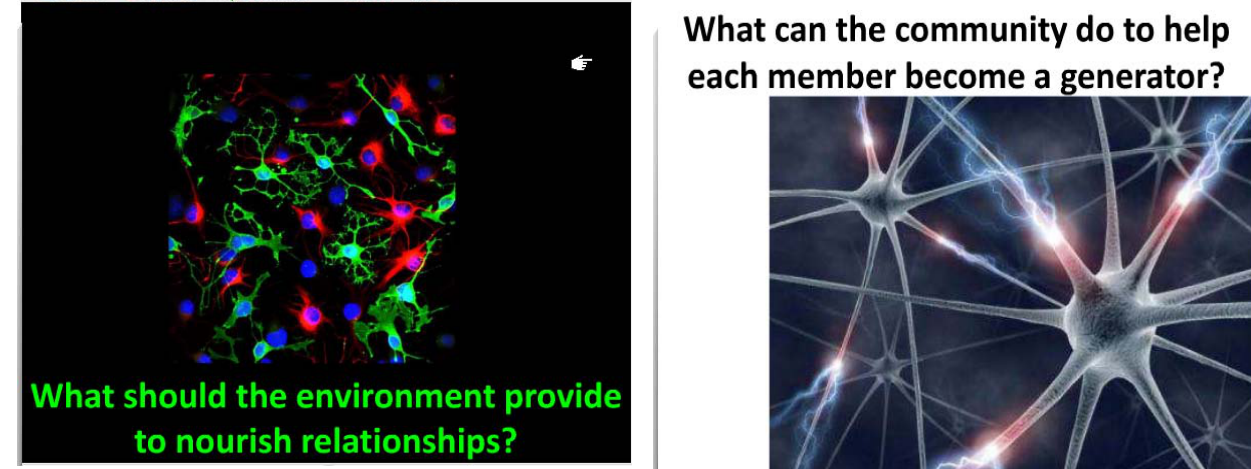
Figure 4 . The learning environment. Figure 5 . The